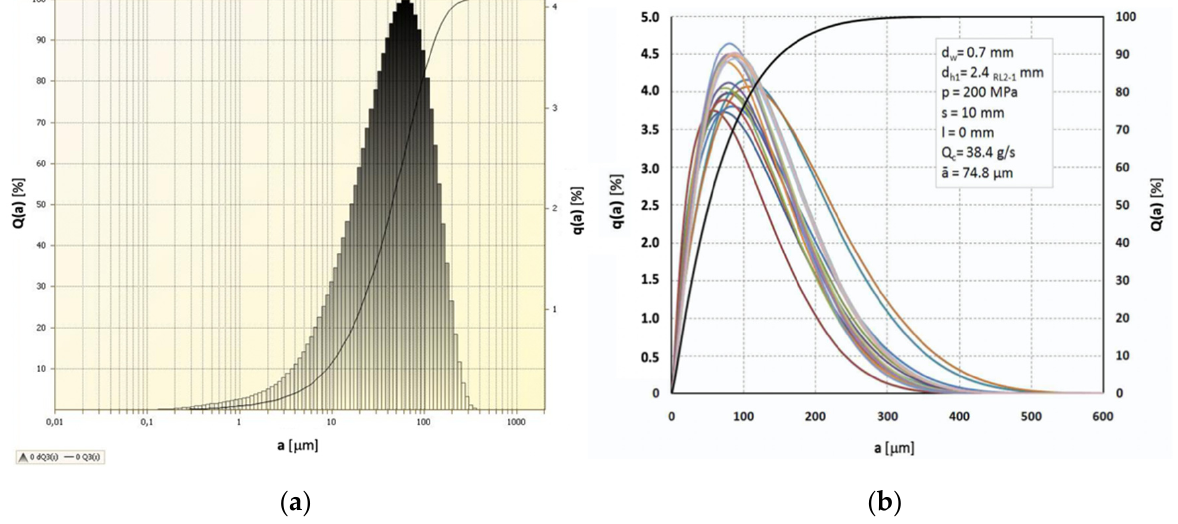
Figure 4. Illustrative distributions of hard coal particles comminuted at water pressure p = 200 MPa: ( a ) typical single histogram distribution in a logarithmic scale of dimensions, and ( b ) comparison of 20 distributions prepared in a linear scale of dimensions.